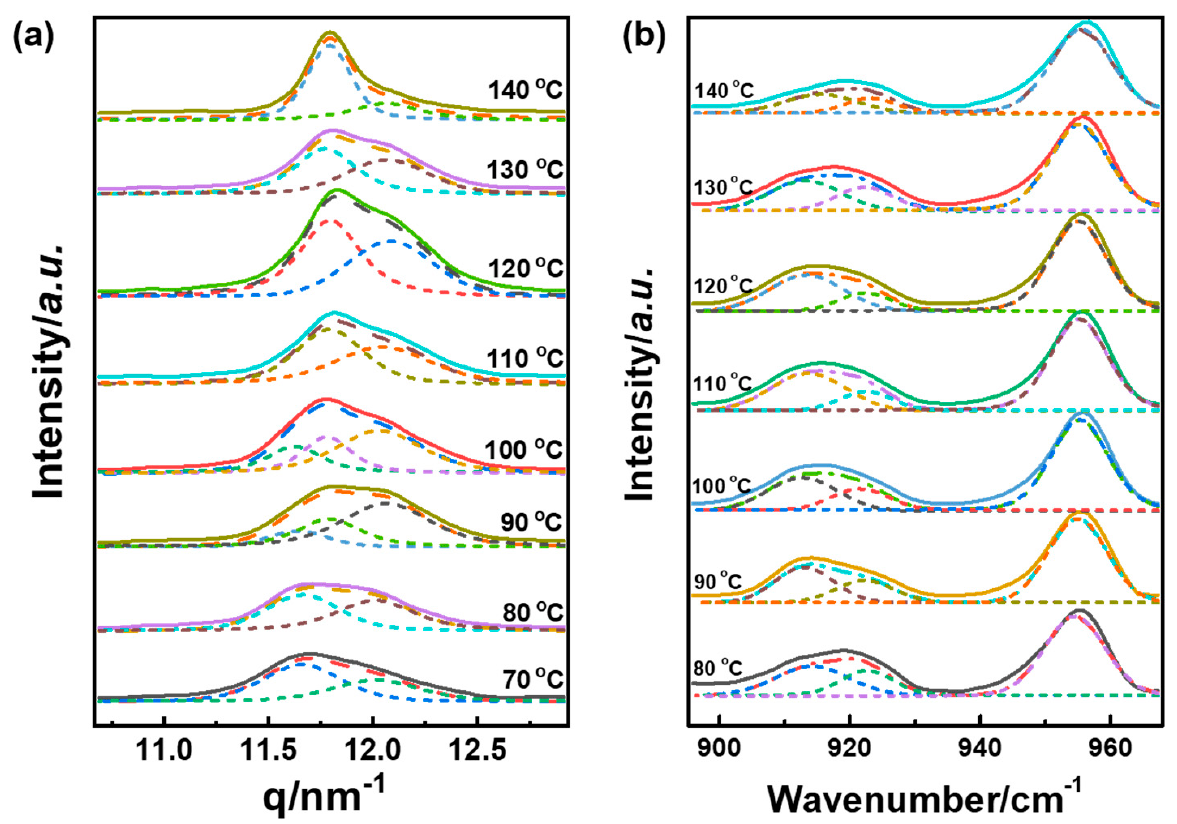
Figure 3. Deconvolution 1D X-ray diffraction profiles ( a ); and FTIR spectra ( b ); (dot line) of PLLA at different friction transfer temperatures. The solid lines are the experimental spectra, the dotted lines are the fitting result.